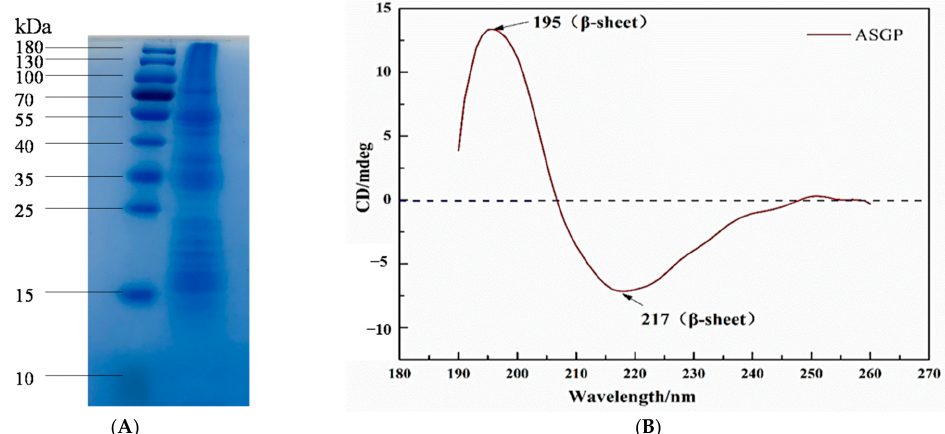
Figure 1. ( A ) SDS − PAGE and ( B ) CD analysis of ASGP. Figure 1. ( A ) SDS-PAGE and ( B ) CD analysis of ASGP.